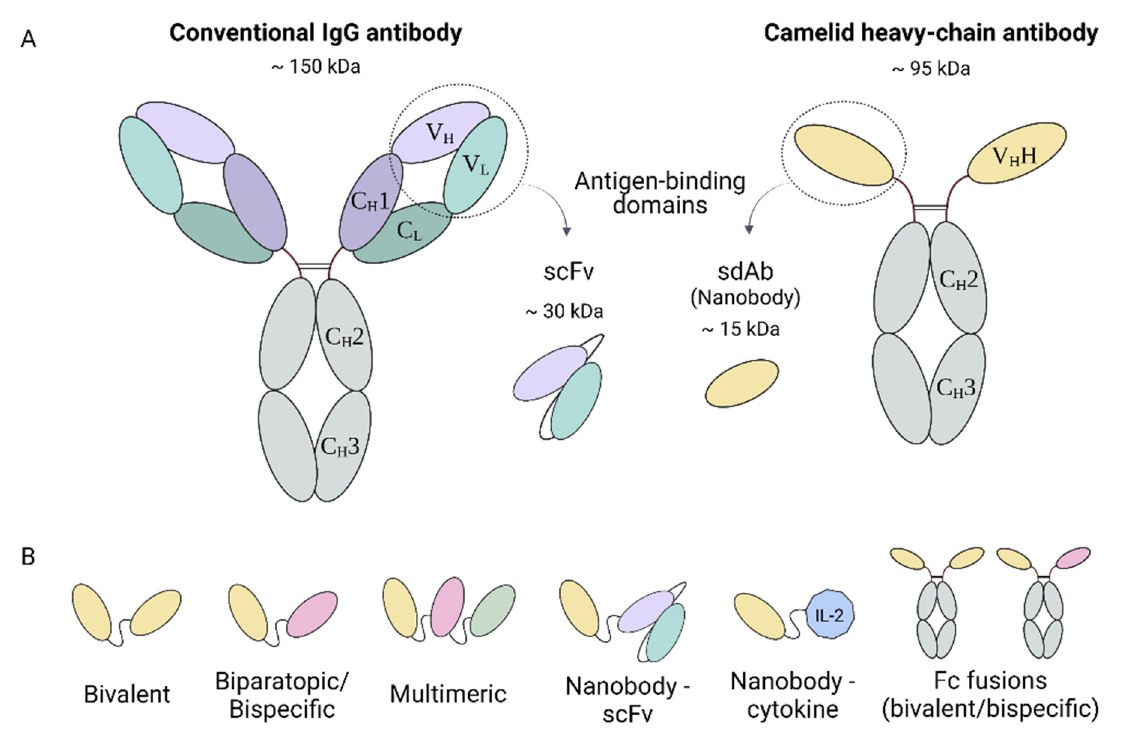
Figure 1. Graphical representation of conventional and heavy-chain antibodies. ( A ) Schematic structure of a conventional IgG antibody, composed by two heavy and two light chains, and a camelid heavy-chain antibody, consisting of two heavy chains. ( B ) Nanobody-based engineered molecules. scFv, single-chain fragment variable.